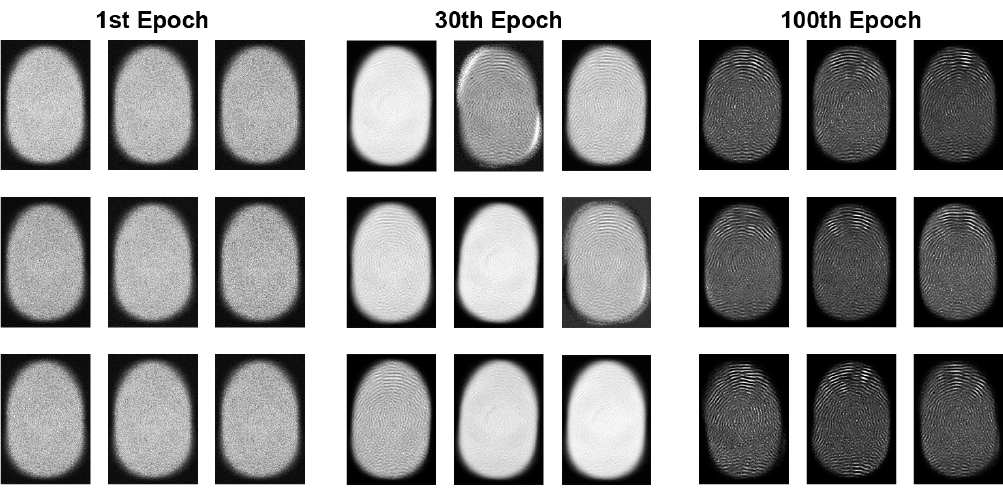
Figure 2. Generated fingerprint images samples through 100 epoch training with an FCN model.